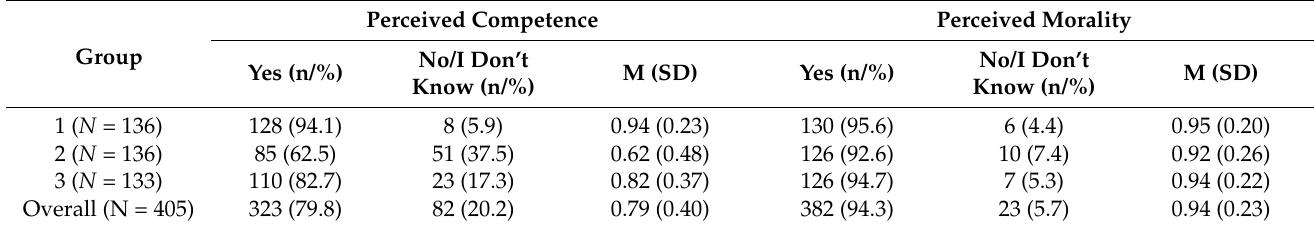
Table 4. Perceived competence and morality ( N =